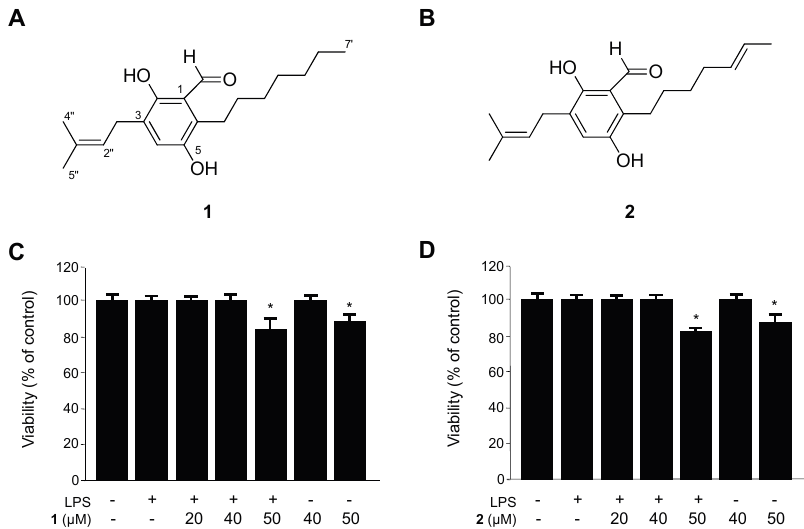
Figure 1. Chemical structures of 1 and 2 ( A , B ) from Eurotium sp. SF-5989, and the effects on cell viability ( C , D ) of RAW264.7 macrophages. RAW264.7 macrophages were incubated for 48 h with the indicated concentrations of 1 and 2 , or pretreated with the indicated concentrations of compounds 1 and 2 for 12 h, and then stimulated with LPS (1 μ g/mL) for 18 h. Data are represented as the mean ± standard deviation (S.D.) of three independent experiments. * p < 0.05 vs.